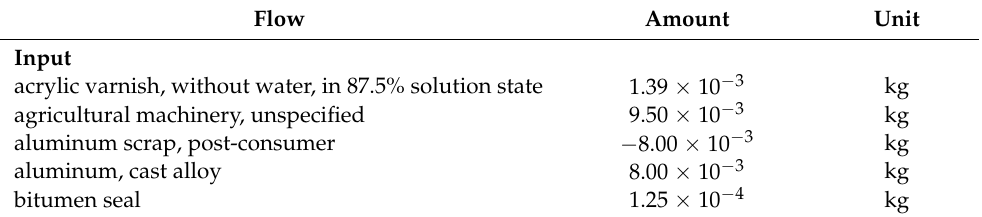
Table A1. Material inventory data for the